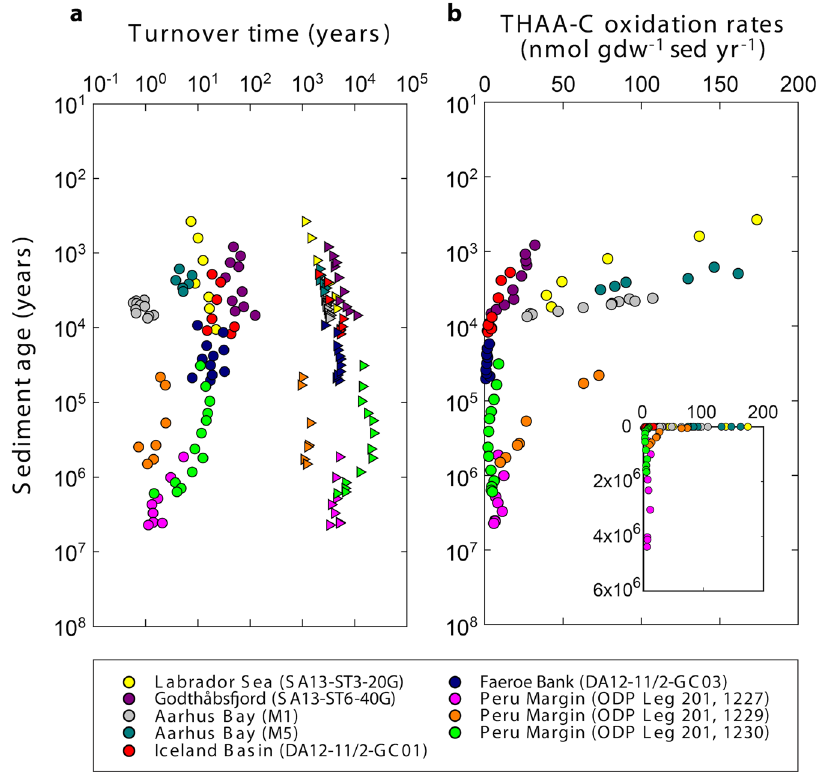
Figure 6. Model-estimated carbon oxidation rates and turnover times of microbial bio- and necromass. ( a ) D:L-amino acid model-estimated turnover times of vegetative cells (circles) and necromass amino acids (triangles) in the seabed. ( b ) Model-estimated oxidation rates of amino acid-carbon (THAA-C) in the samples. The unit ‘per gram dry weight sediment per year’ is abbreviated with ‘gdw − 1 sed yr − 1 ’. Note that sediment ages are on logarithmic scales. Insert in ( b ) has a linear age scale for better comprehension of the time